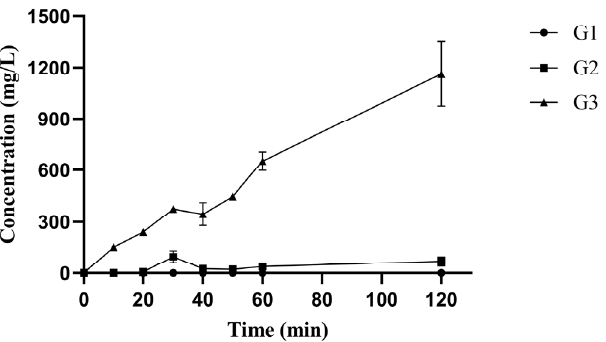
Figure 3. HPAEC-PAD analysis of products by pePGA on polygalacturonic acid. G1: mono- Figure 3. HPAEC ‐ PAD analysis of products by pePGA on polygalacturonic acid. G1: mono ‐ galac ‐ galacturonic acid, G2: di-galacturonic acid, G3: tri-galacturonic acid. turonic acid, G2: di ‐ galacturonic acid, G3: tri ‐ galacturonic acid.